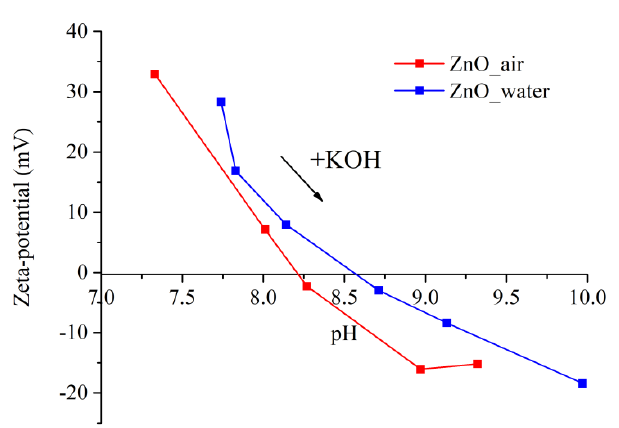
Figure 8. Zeta potential of NPs evaluated at different pH values. Blue and red symbols stand for samples prepared in water and air, respectively.